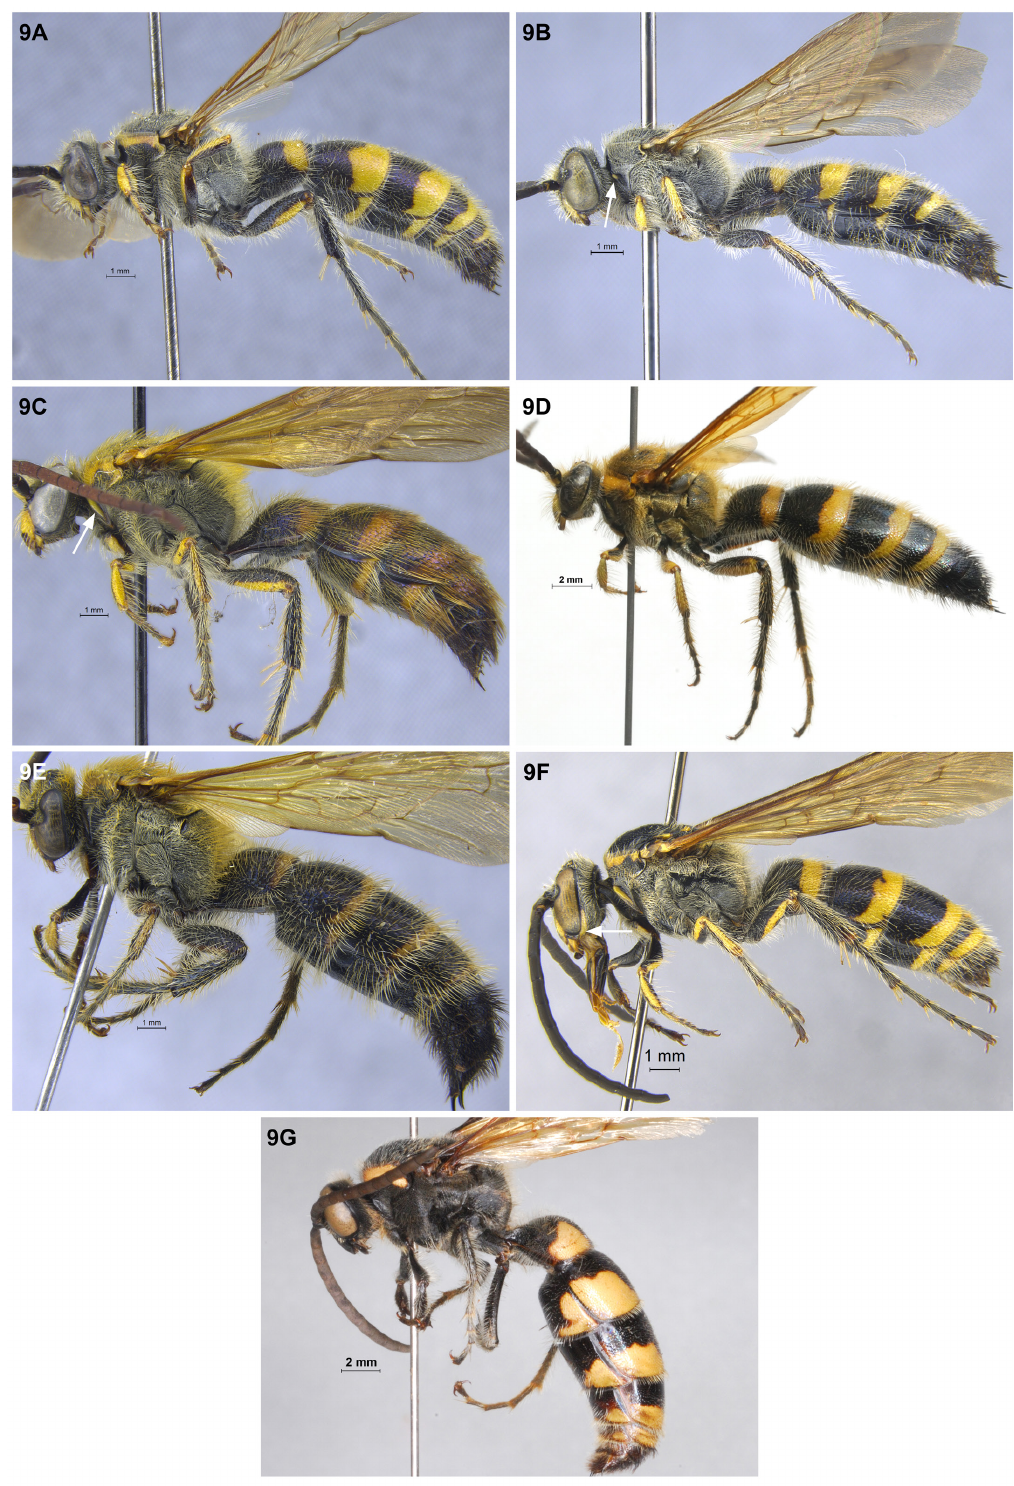
Fig. 9. Males, lateral habitus. A . Campsomeriella annulata annulata (Fabricius, 1793). B . Camps. collaris (Fabricius, 1775). C . Megacampsomeris sp. 1. D . Megacam. formosensis chinensis Betrem, 1941. E . Megacam. prismatica (Smith, 1855). F . Phalerimeris phalerata phalerata (de Saussure, 1858). G . Sericocampsomeris flavomaculata Gupta & Jonathan,